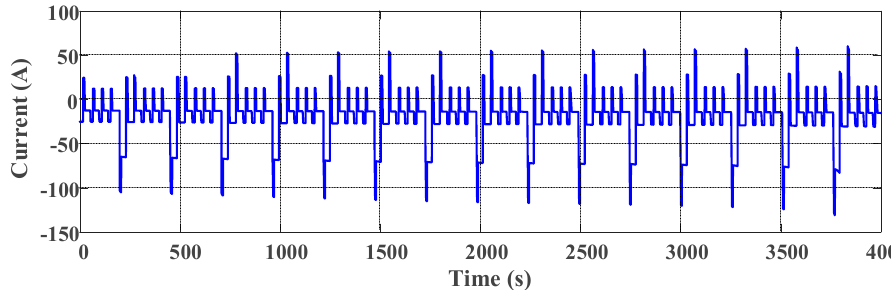
Figure 4. Current profile of the dynamic stress test (DST) test cycle condition.